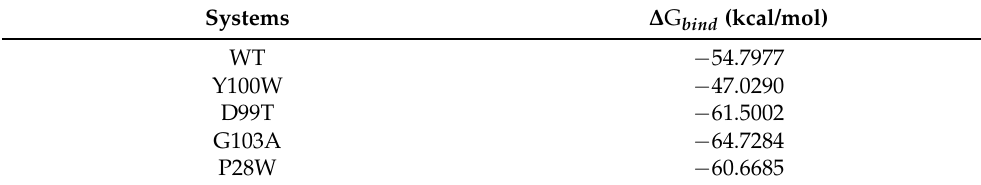
Figure 9. RMSD and RMSF analysis of wild-type and mutant type: ( A ) RMSD analysis; ( B ) RMSF analysis of residues in the RBD region; ( C ) RMSF analysis of residues in the heavy chain of the antibody; ( D ) RMSF analysis of residues in the light chain of the antibody. Table 4. Binding free energy of wild-type and mutant